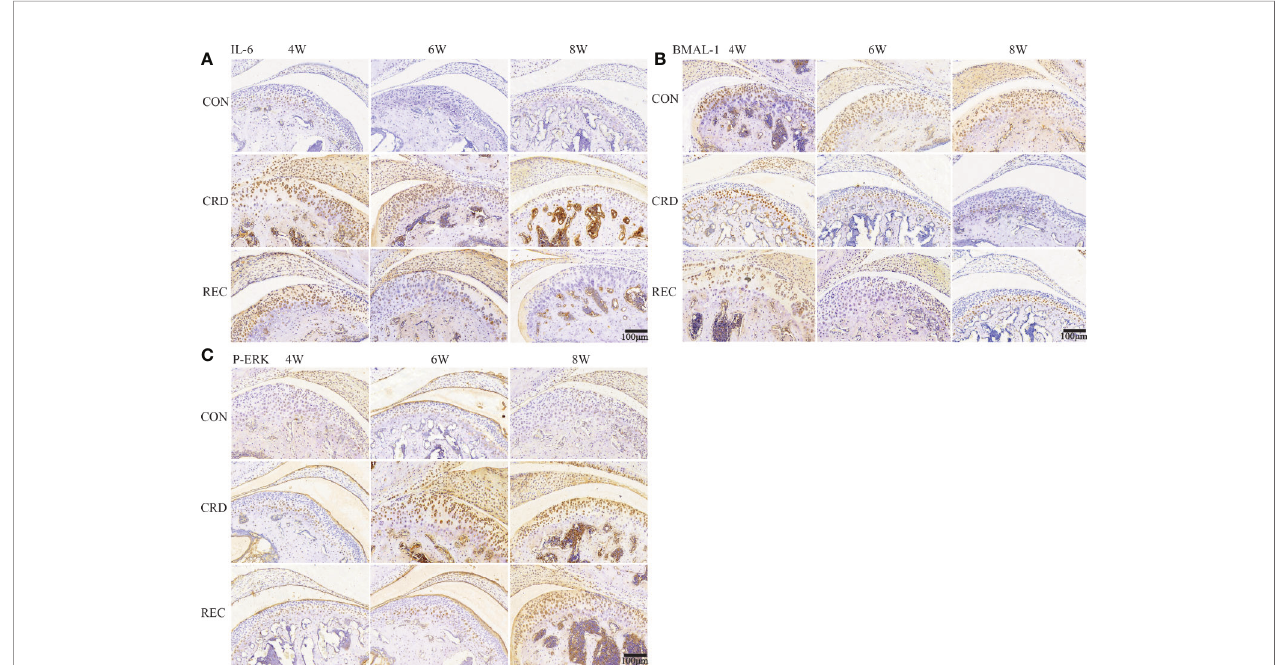
FIGURE 2 | IL-6, BMAL-1, and P-ERK protein expression in rat condylar cartilage. Representative images of immunohistochemistry staining for IL-6 (A) , BMAL-1 (B) , and P-ERK (C) in the CON, CRD, and REC groups. All experiments were performed in triplicate, and the results are expressed as the mean ± SD. Scale bar: 100 m